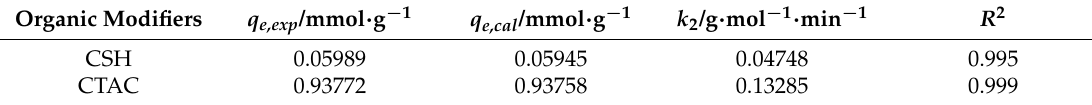
Figure 4. Pseudo-second-order model plots of CTAC ( a ) and CSH ( b ) onto Mt. Table 1. Kinetic parameters of CTAC and CSH adsorption onto Mt.